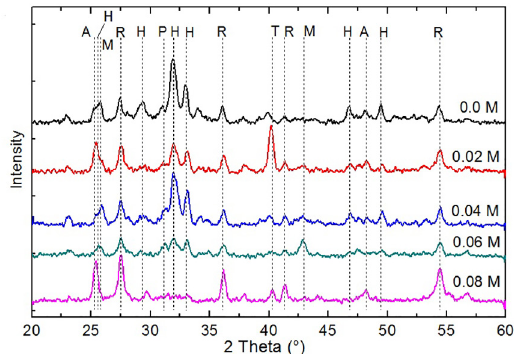
Figure 9. XRD patterns of coatings produced by PEO with different C , where the letters stand for: H - Hydroxyapatite; P - Calcium M Phosphate, R - Rutile, M - Magnesium phosphide, A - Anatase, and T - titanium.